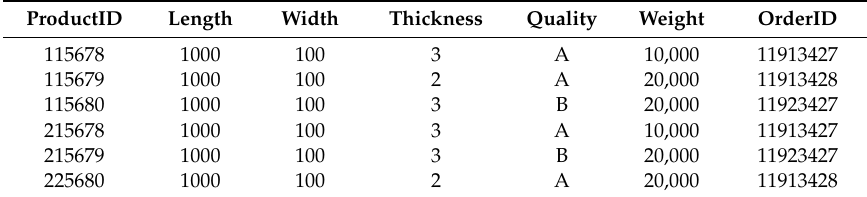
Table 2. Product information.